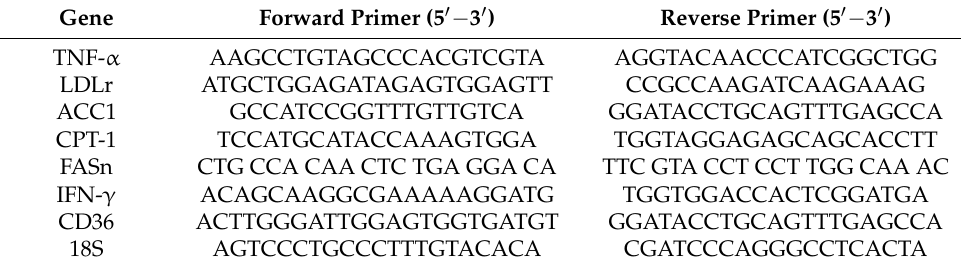
Table 1. Primer sequences for quantitative real-time PCR analysis. Gene Forward Primer (5 (cid:48) − 3 (cid:48) ) Reverse Primer (5 (cid:48) − 3 (cid:48)